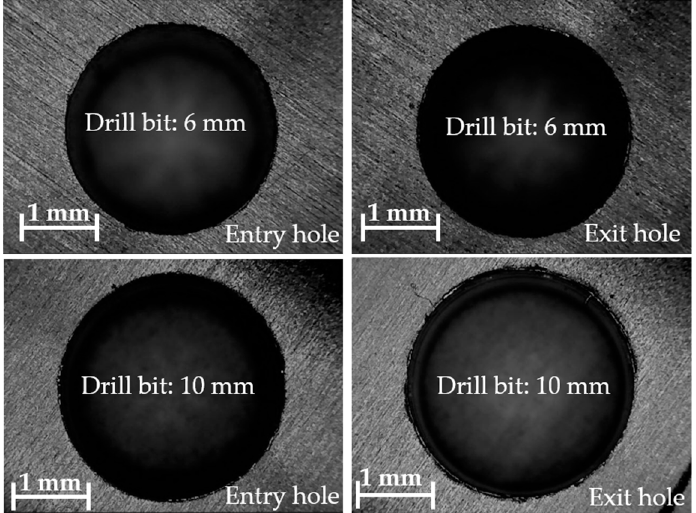
Figure 4. Quality of holes in terms of burrs at 3000 rpm and 0.14 mm/rev.